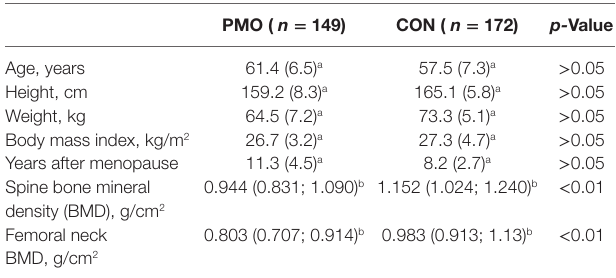
taBLe 1 | Clinical characteristics of analyzed patients with postmenopausal osteoporosis (PMO) and control (CON)